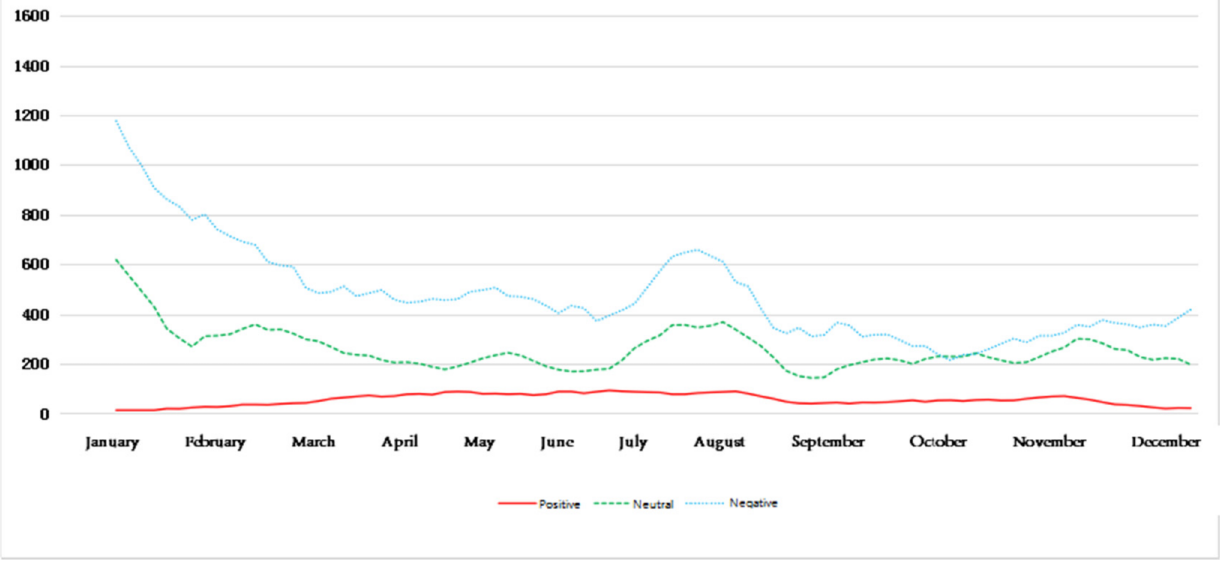
Figure 10. Five-day moving average of perceived emotions in